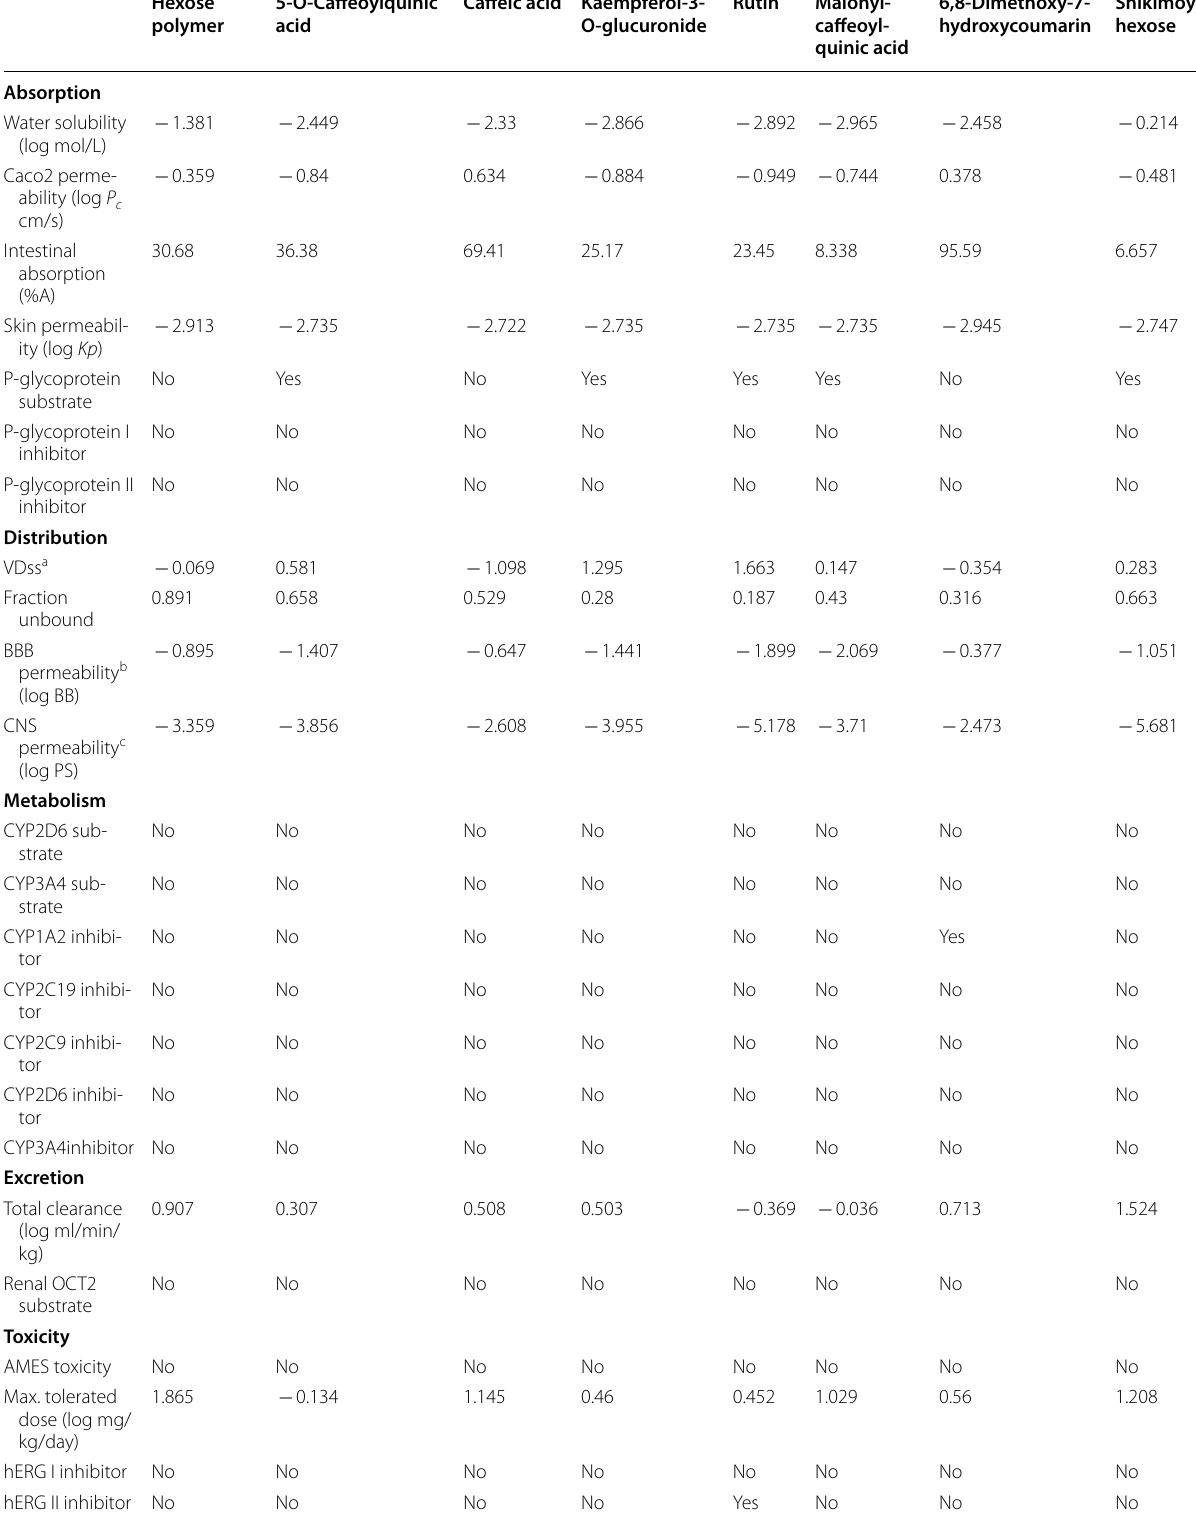
Table 4 The ADMET parameters of polyphenols from M. fruticosa spp. brachycalyx via pkcsm software Hexose